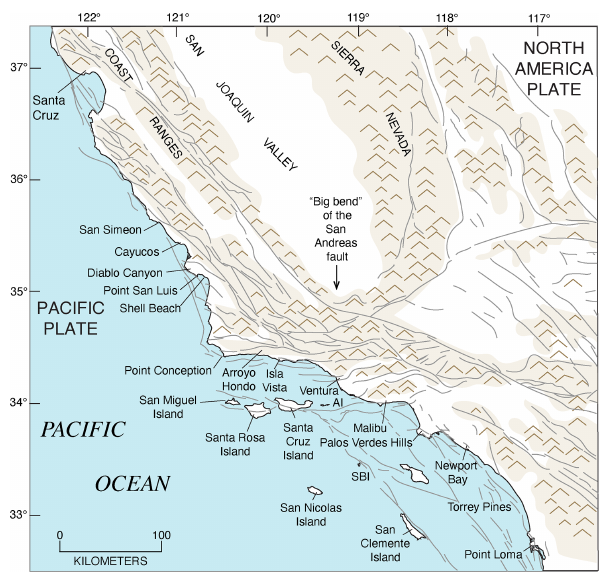
Figure 25. Map of geographic features in southern California and localities referred to in the text. Grey lines are faults from Jennings (1994). AI: Anacapa Island; SBI: Santa Barbara